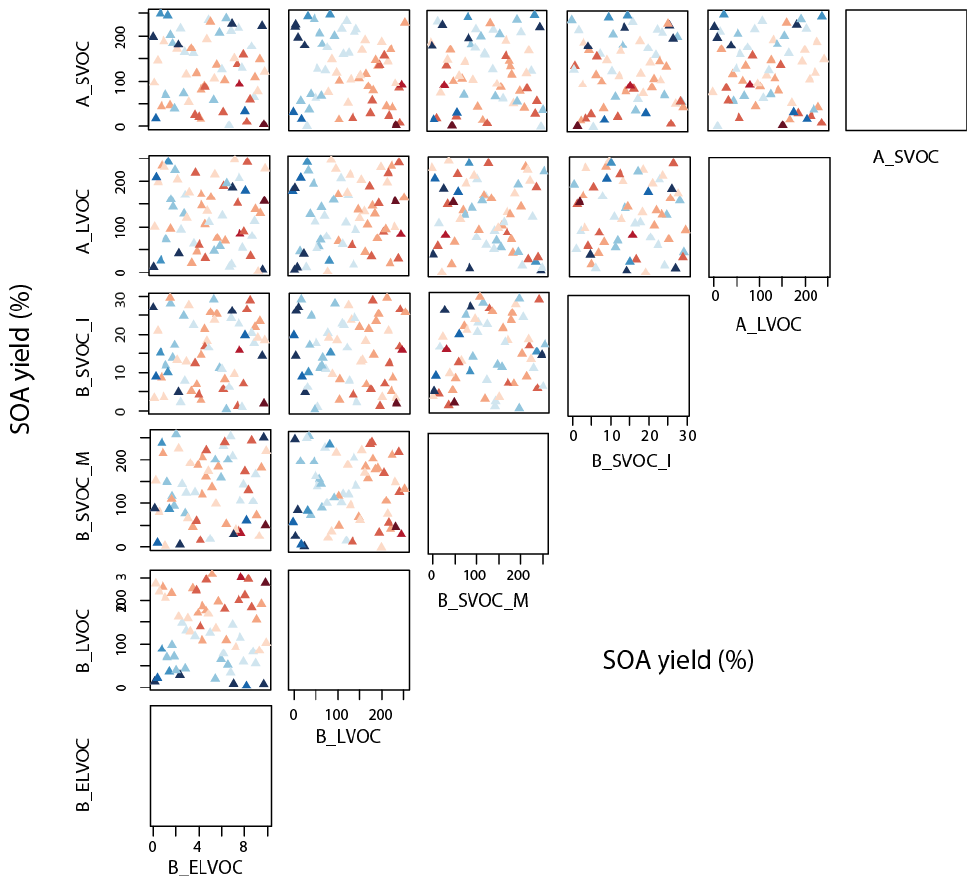
Figure 11. Taylor skill score for model simulations against N50 observations across the 6-D parameter space. The x and y axes for a subplot show the total range of reaction yields (%) over which each of the two parameters (as indicated by the plot labels at the top and right for each subplot respectively) is perturbed in the ensemble. Each triangle in a subplot represents a simulation and the color of the triangle indicates its Taylor skill score for N50. Darker shades of blue indicate low/poor Taylor skill score and darker shades of red represent high/good Taylor skill score. Figure A4 shows the same plot with ensemble members numbered. Note the axis for B_ELVOC shows the scaling factor for B_ELVOC yields. Axes for the rest show the corresponding ox-VOC